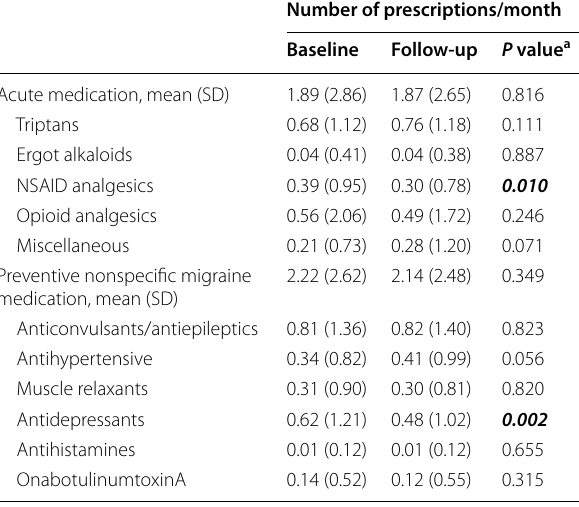
Table 3 Acute and preventive medication prescription trends among persistent ( 6 months) patients with a defined dose ≥ ( n 746) =